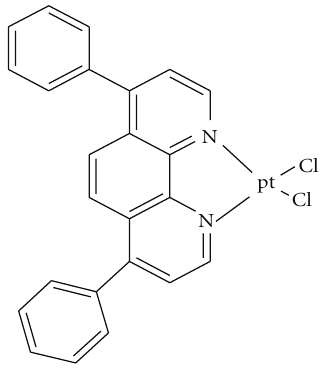
Figure 1: Schematic structure of PtCl 2 (DIP) (DIP = chelating dinitrogen ligand: 4,7-diphenyl-1,10